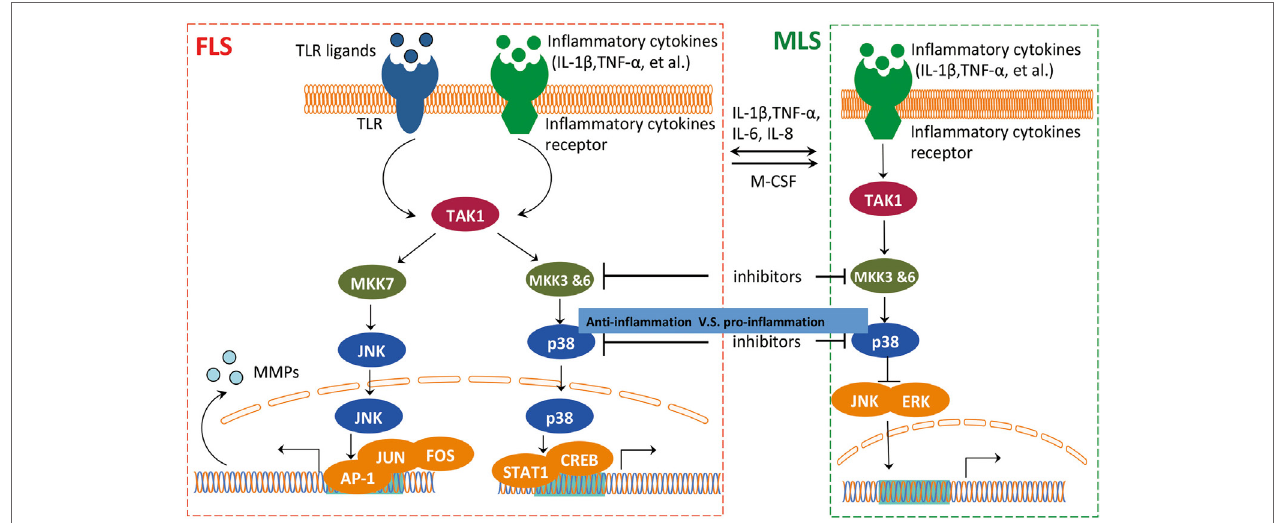
FiGuRe 4 | The interaction between FLS and MLS in RA. FLS and MLS cross talk through secreted cytokines and MAPK pathway. FLS and MLS mutually activate via cytokines production; in addition, the pro-inflammatory and anti-inflammatory contest highlights the important role of the interaction between MLS and FLS via MAPK pathway in RA. Abbreviations: MAPK, mitogen-activated protein kinase; TAK1, TGF-beta activated kinase 1; MKK3, MAP kinase kinase 3; MKK6, MAP kinase kinase 6; MKK7, MAP kinase kinase 7; JNK, c-Jun N-terminal kinases; AP-1, APETALA 1; FOS, FBJ murine osteosarcoma viral oncogene homolog; STAT1, signal transducer and activator of transcription 1; CREB, cAMP responsive element binding protein 1; ERK, extracellular signal-regulated kinase; MSL, macrophage- like synoviocytes; FSL, fibroblast-like synoviocytes; RA, rheumatoid arthritis.